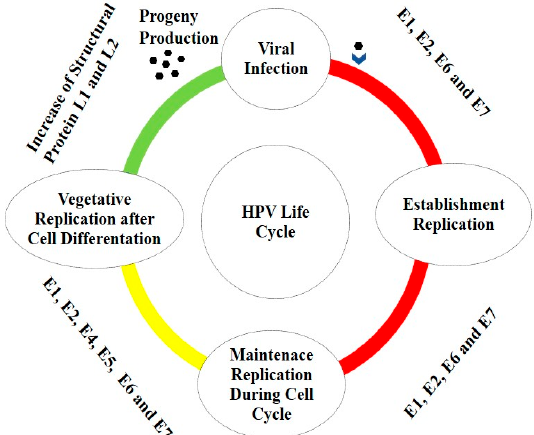
Figure 1. HPV life cycle. The first step of the replication cycle of HPV, called establishment replication, consists of maintaining a constant number of episomal copies. After this initial step, the maintenance phase is initiated. This phase consists of creating the conditions to maintain a constant number of viral genomes in the nuclei of undifferentiated basal cells, to create a persistent infection. E1, E2, E6 and E7 are required for stable episomal maintenance of HPV. Finally, vegetative or productive viral replication is initiated with the subsequent production of progeny virions.